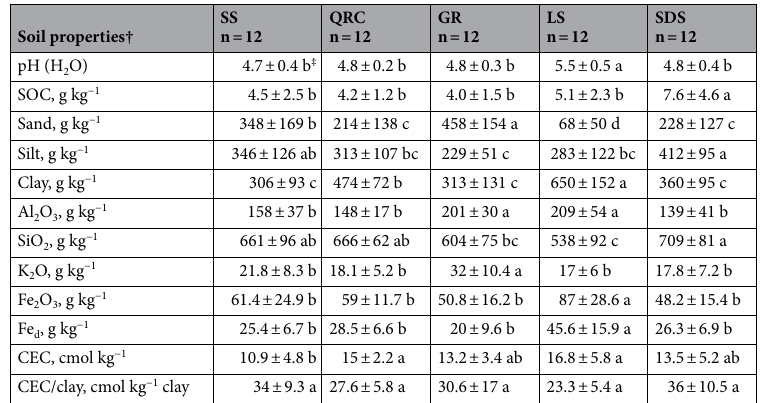
Table 2. Physicochemical properties of upland soils derived from different parent materials in Hunan Province, China. †SOC: soil organic carbon; CEC: cation exchange capacity; CEC/clay, cation exchange capacity of the clay fraction; Fed: dithionite-citrate-bicarbonate (DCB)-extractable. ‡ Mean ± standard deviation. Means followed by different letters indicate the data were statistically different at P < 0.05 among different parent